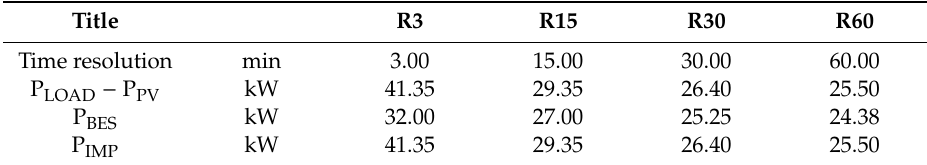
Table 6. Peak values during low generation.